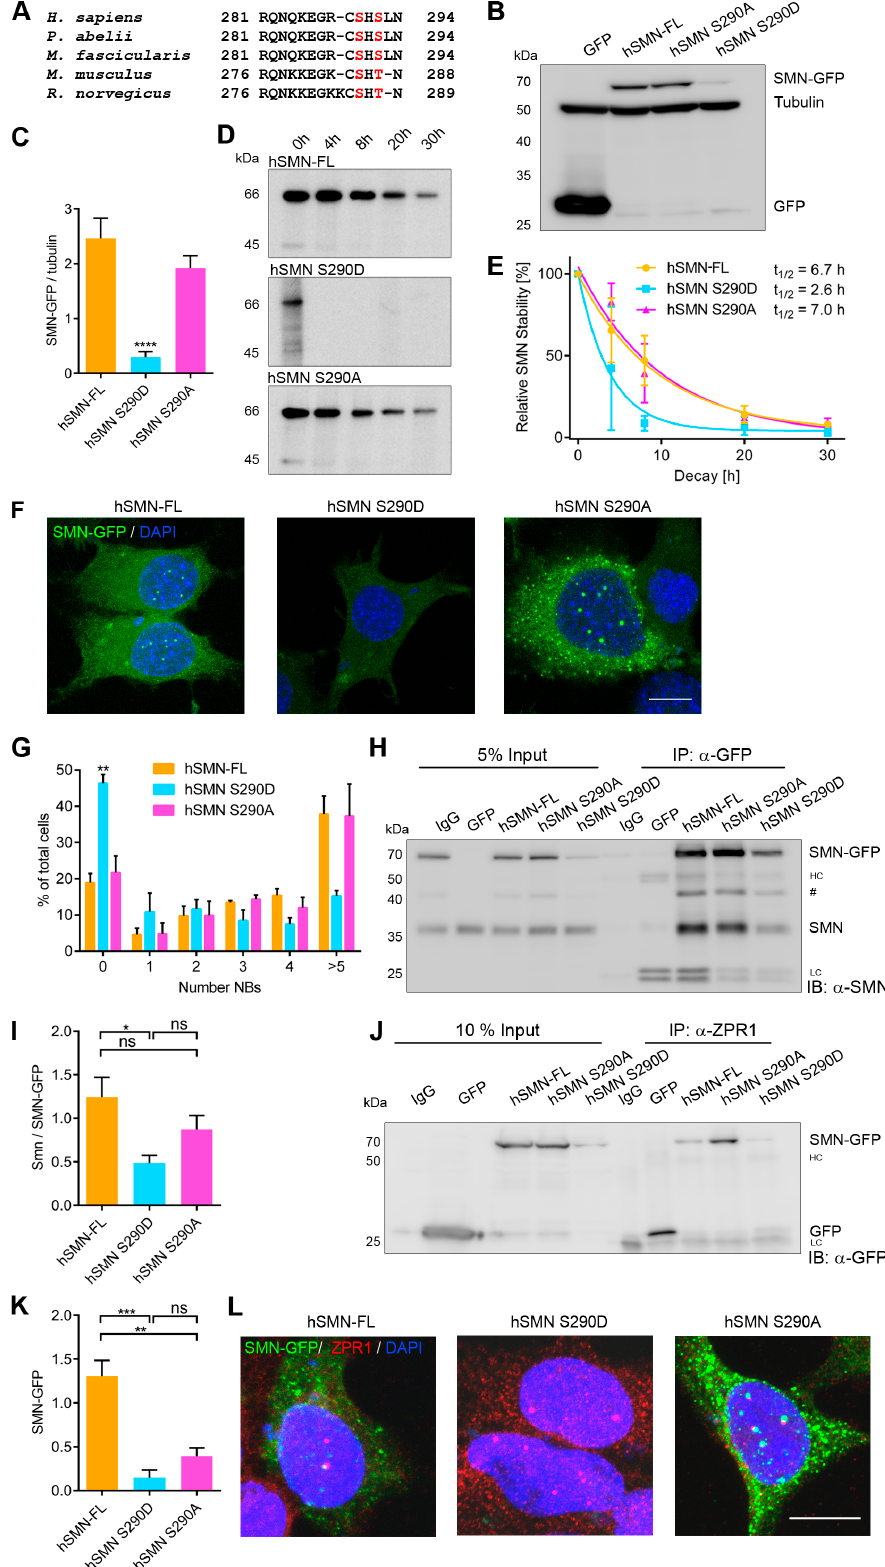
Figure 2. Characterization of hSMN S290 phospho-mutant and phospho-mimetic. ( A ) Multiple sequence alignment of the C-termini of SMN from different species showing conservation of serine 290 residue. ( B , C ) Expression of hSMN-FL, hSMN S290D and hSMN S290A in NSC34 cells by Western